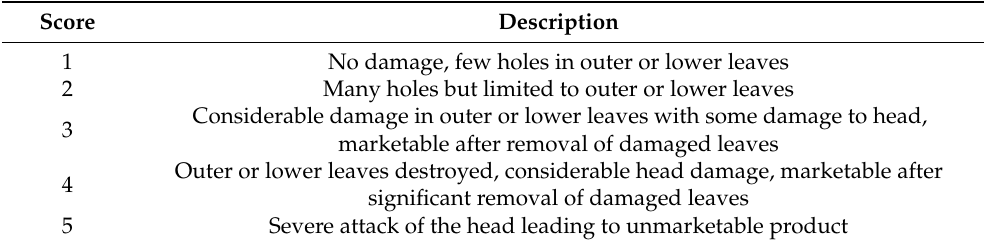
Table 2. Damage assessment